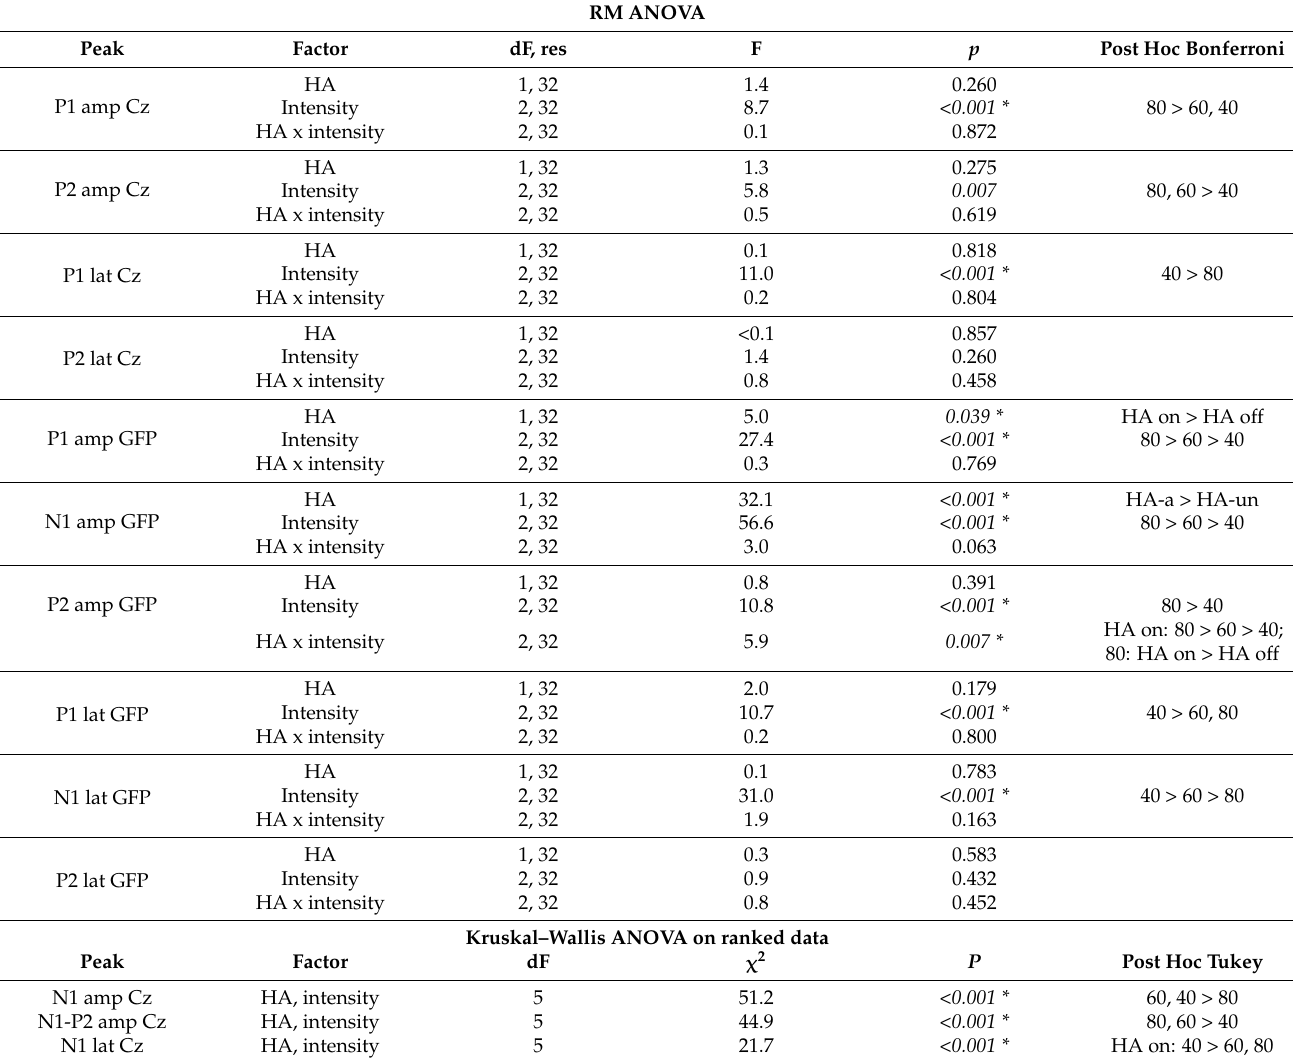
Table 4. Results of RM ANOVAs performed on HA CAEP amplitude and latency data (aided and unaided) at Cz and for global field power (GFP); in cases where assumptions of normality and equal variance were violated, non-parametric tests were performed (shown in lower part of the table). For the HA factor, the HA was on or off. Significant effects are indicated by asterisks and italics; post hoc significant differences are shown after Bonferroni or Tukey correction for multiple